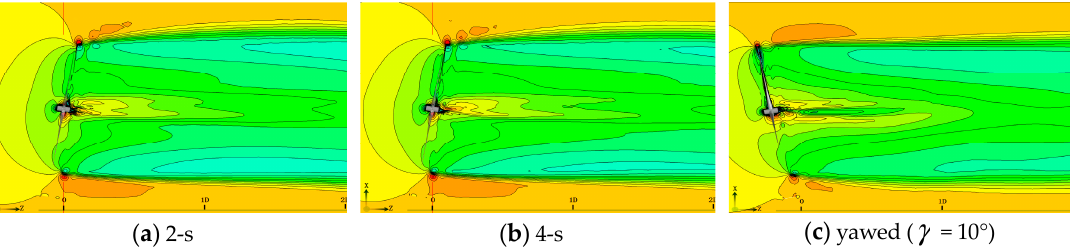
Figure 20. Velocity contours for Case 2.